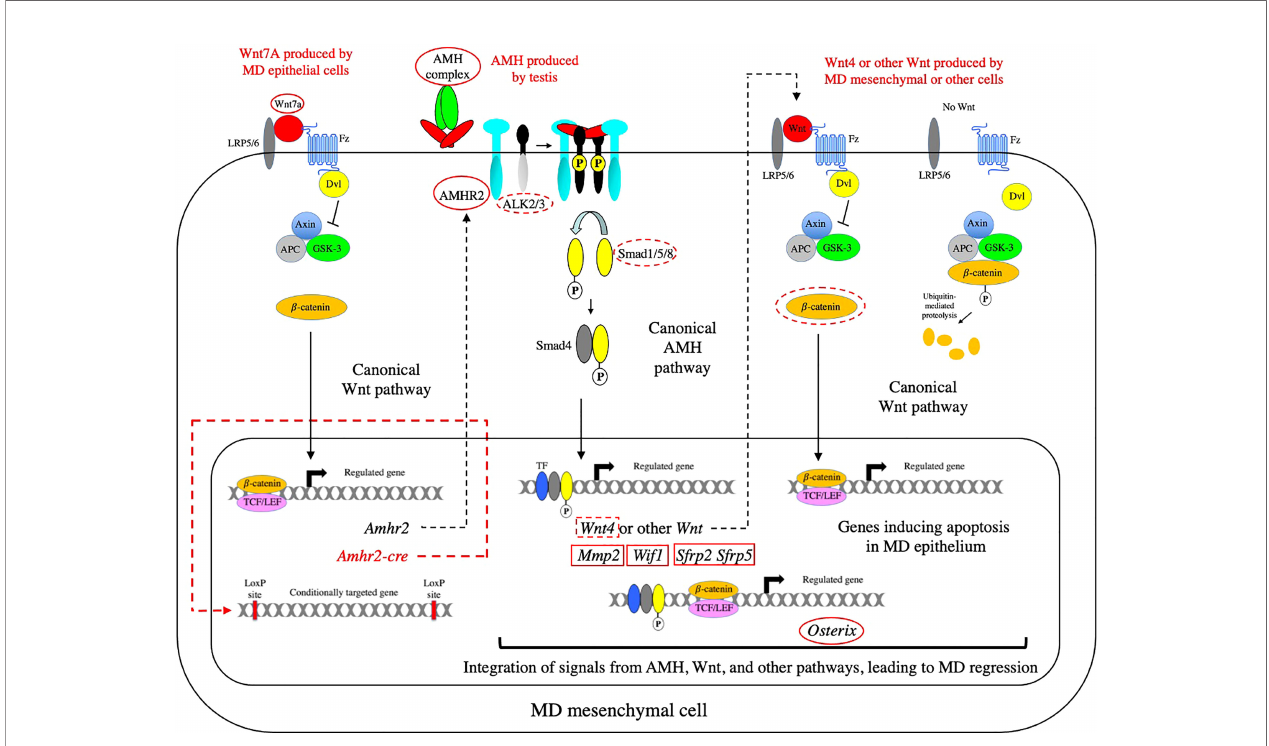
FIGURE 7 | The network of signaling pathways required for MD regression. The AMH canonical signaling pathway is shown in relation to the upstream and downstream Wnt canonical pathways that are required for MD regression. The canonical Wnt pathway on the right of the diagram shows how catenin is degraded in the absence of a Wnt signal. In the absence of Wnt signaling, TCF factors associate with Groucho family proteins to repress transcription (not shown). When Wnt binds to its receptors (Fz and LRP5/6), Disheveled (Dvl) is recruited and activated, resulting in the inhibition of the serine/threonine kinase, GSK-3, and leading to the accumulation of b -catenin and its translocation to the nucleus. In the nucleus, b -catenin displaces Groucho to bind TCF/LEF and activate transcription. Genes or proteins that affect MD regression as null mutations or conditional knockouts are indicated with red solid or dashed ovals, respectively. Genes that do not affect MD regression as null mutations or conditional knockouts are indicated with red solid or dashed rectangles, respectively. b -catenin is not circled in the Wnt7a pathway shown on the left because the conditional knockout of b -catenin did not affect expression of AMHR2. Since both Amhr2 and the Cre-recombinase (under the control of the Amhr2 promoter) would be induced at the same time, there is almost certainly a time delay between establishment of a competent AMH signaling pathway and the inactivation of b - catenin in the Wnt7a pathway required for the induction of AMHR2. Fz, Frizzled; LRP5/6, LDL-receptor-related protein 5/6; APC, adenomatous polyposis coli